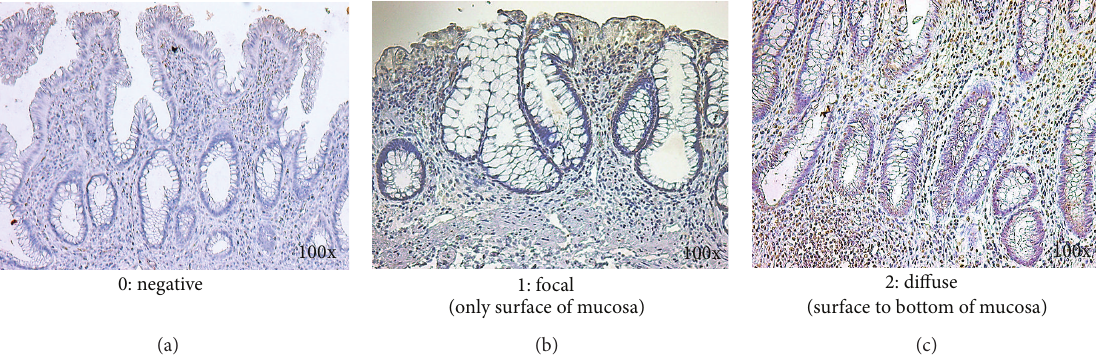
Figure 2: Immunohistochemical findings for CCR6 in the rectal mucosa. CCR6 expression was observed in the nucleus or cytoplasm of epithelial cells, infiltrating inflammatory cells, and endothelial cells. Different grades of CC6 infiltrating pattern in epithelia were evaluated as follows: grade 0 (negative, (a)), 38 specimens; grade 1 (focal, (b)), 59 specimens; grade 2 (diffuse, (c)), 44 specimens, respectively. Original magnification, 100x.